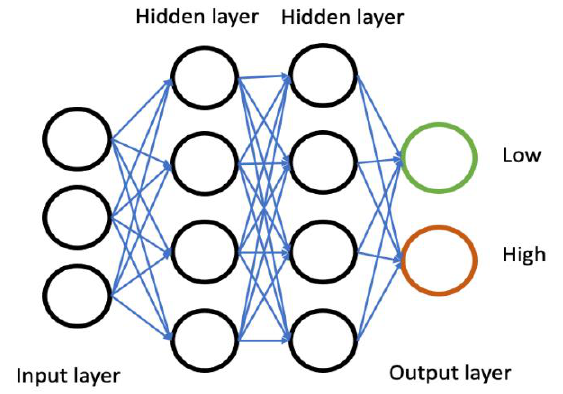
Figure 2. Architecture of deep learning algorithms.